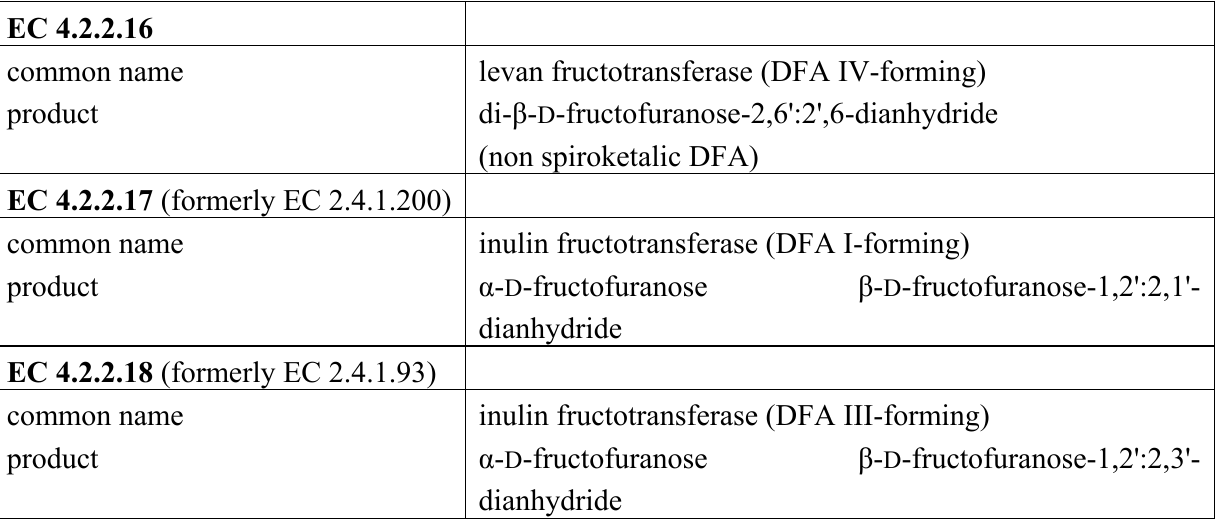
Table 5 . Nomenclature of DFA-producing